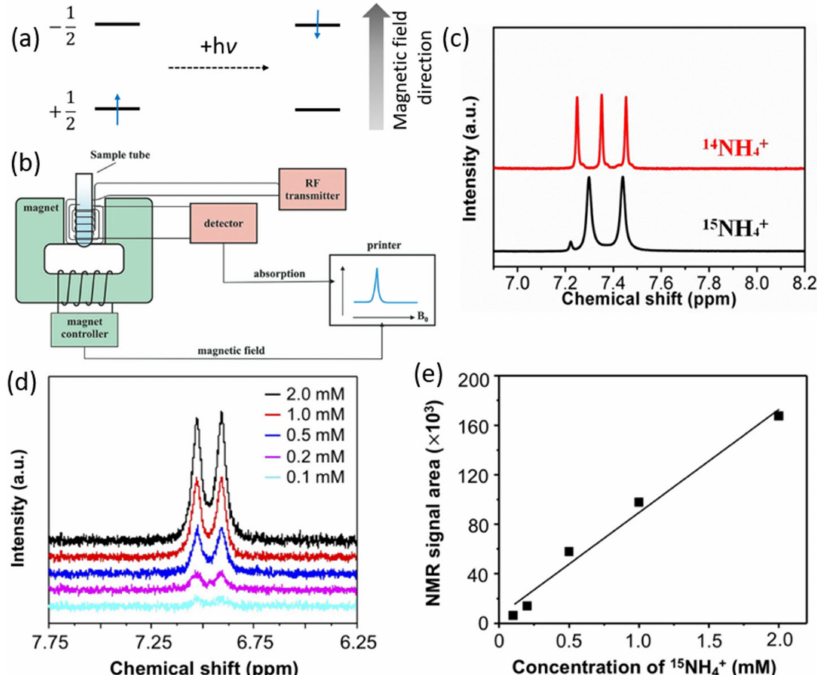
Figure 5. ( a ) Absorption process in NMR. ( b ) Schematic representation of a typical NMR spectrometer. Adapted with permission from Ref. [52] Copyright 2019, Georg Thieme Verlag KG. ( c ) 1 H NMR spectra of 14 NH 4+ and 15 NH 4+ produced from NRR reaction using 14 N 2 and 15 N 2 isotopes. Adapted with permission from Ref. [45] Copyright 2021, Royal Society of Chemistry. ( d ) 1 H NMR spectra of 15 NH 4+ standard solutions with various concentrations and ( e ) corresponding calibration